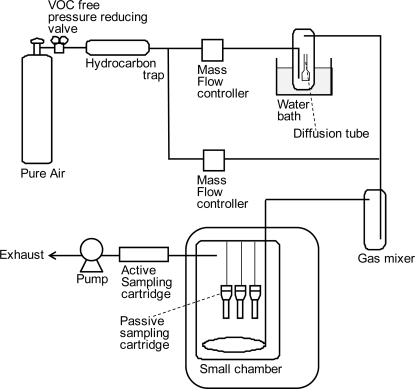
System for measurement of PFT sampling rate.